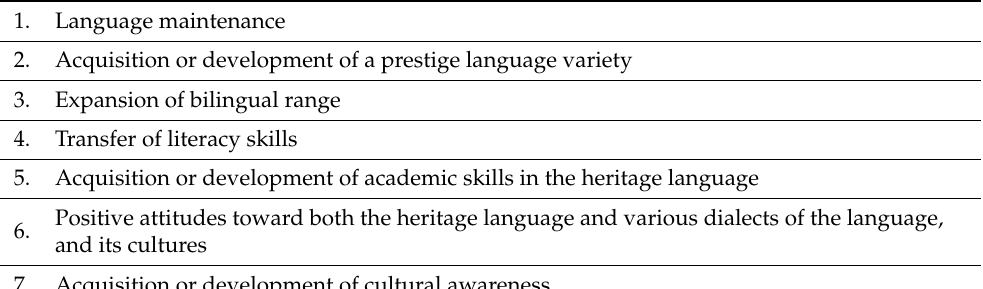
Table 1. Goals of Heritage Language Instruction (Beaudrie et al. 2014, p.